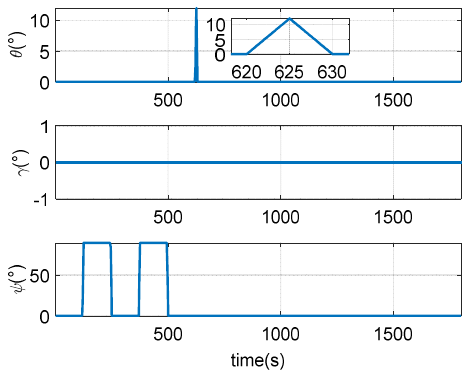
Figure 7. The attitude change of the vehicle.